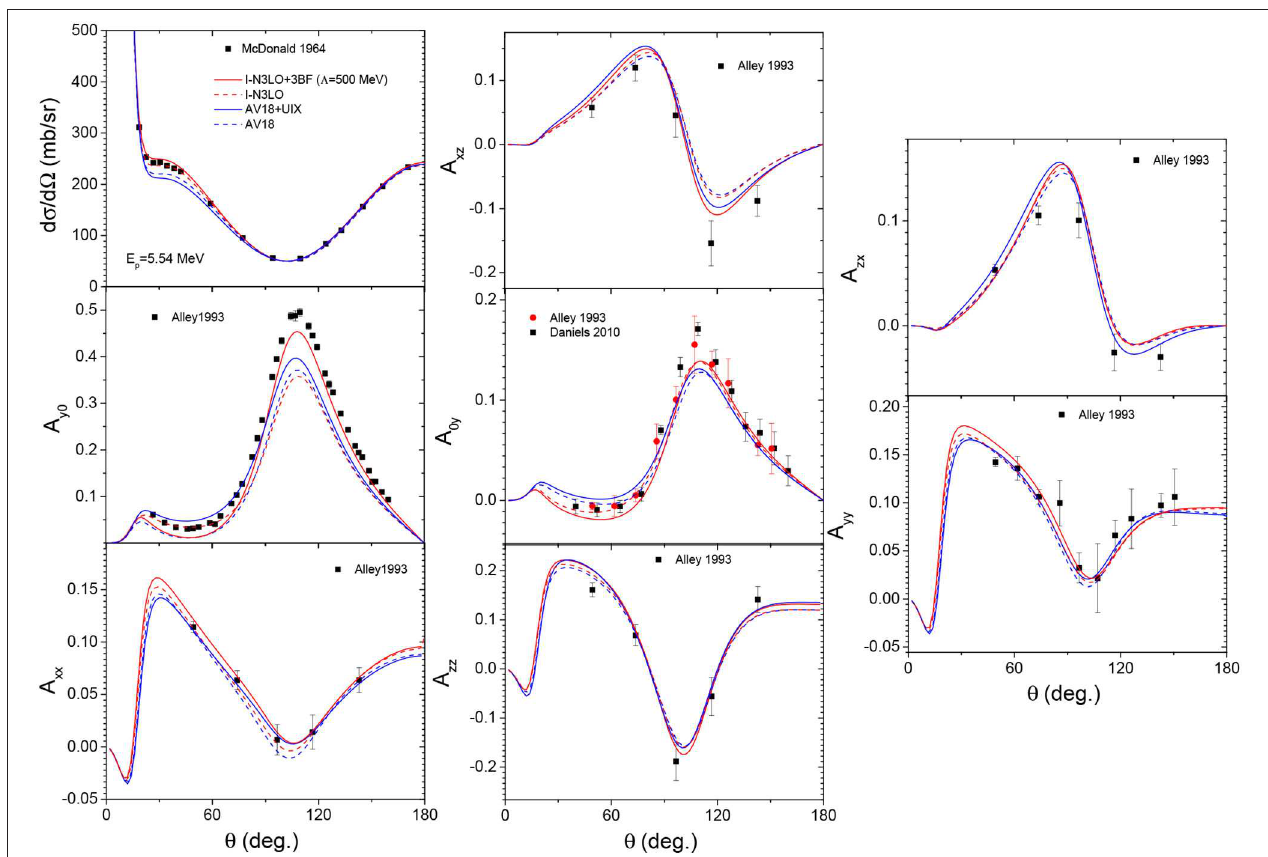
FIGURE 6 | Various differential observables calculated for proton scattering on 3 He at 5.54